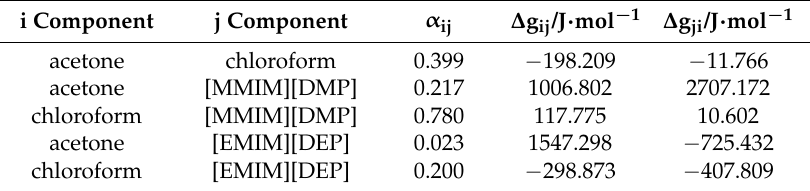
Table 1. Calculated Values of Binary Parameters ∆ g ij and ∆ g ji in the Nonrandom Two-Liquid (NRTL)